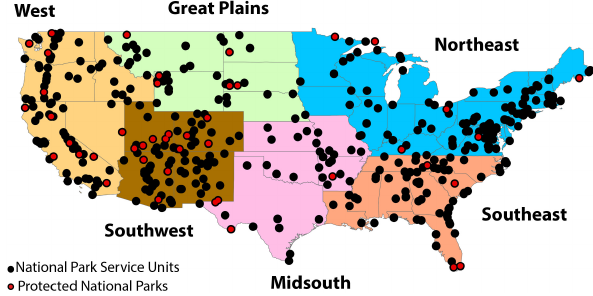
Figure 4. Location of the US national park units and wilderness areas used in this study. The US protected national parks are high- lighted in red; the six US climatic regions are also